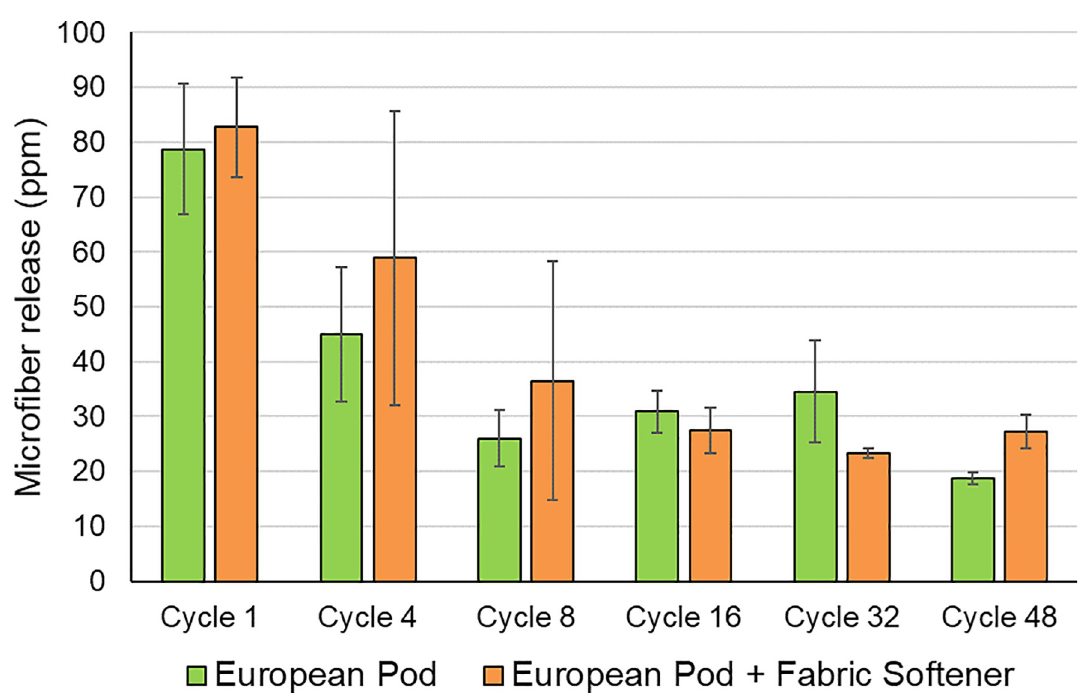
Fig 7. Impact of fabric softener on microfiber release from polyester fleece: European conditions (n = 36). Error bars represent the standard deviation.